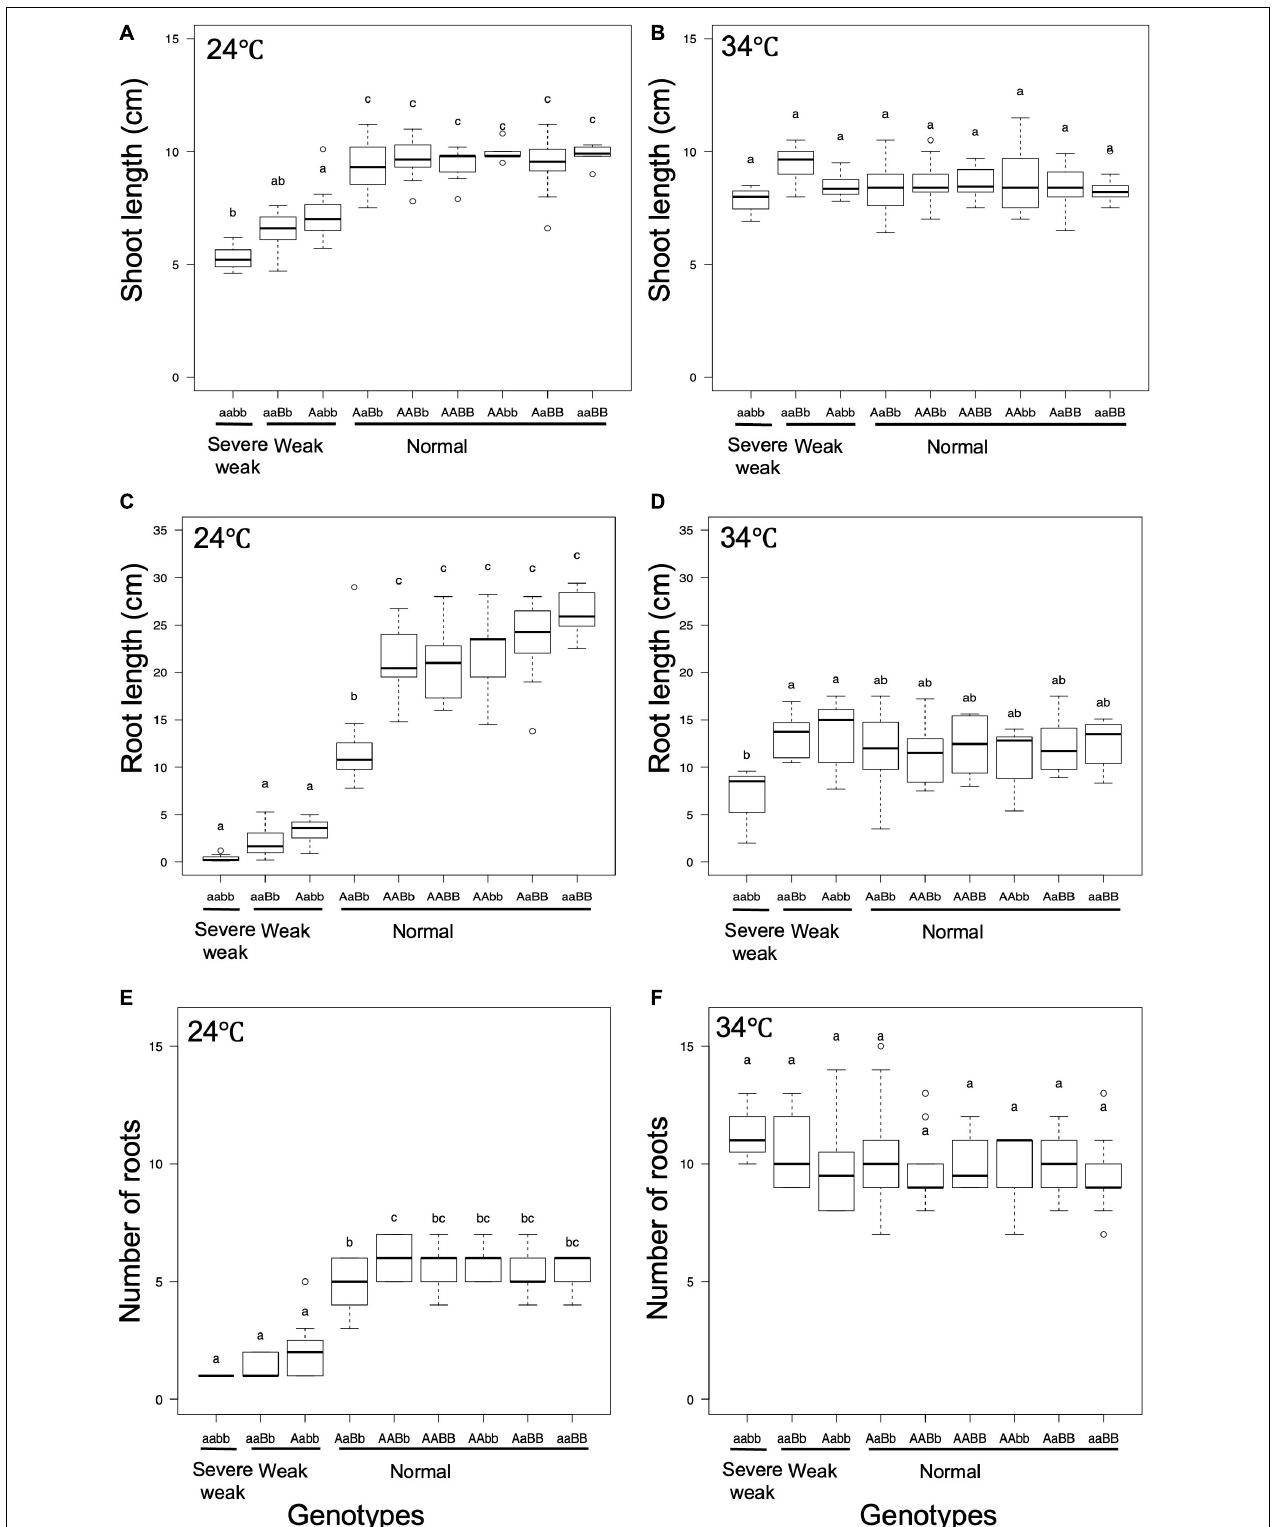
FIGURE 8 | Boxplots of phenotypic evaluations of (A,B) shoot length, (C,D) root Length, and (E,F) number of roots of 10-day-old seedlings grown at 24 and 34 ◦ C. Different letters in each phenotype represent significant differences among the genotypes based on one way ANOVA followed by Tukey’s HSD test ( p < 0.05).